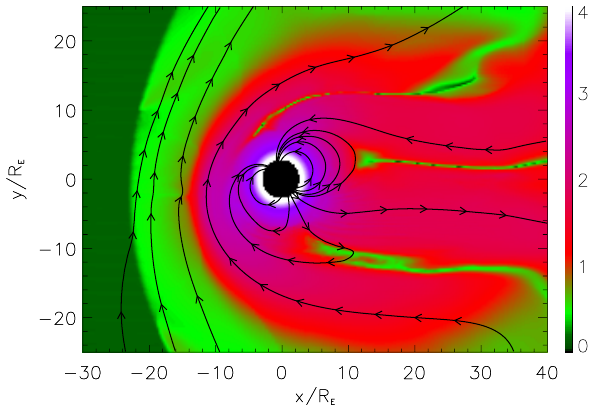
Fig. 11. Magnetic field variations, corresponding to Fig. 6. The present case has a tilt of π/ 6 for the magnetic dipole axis.